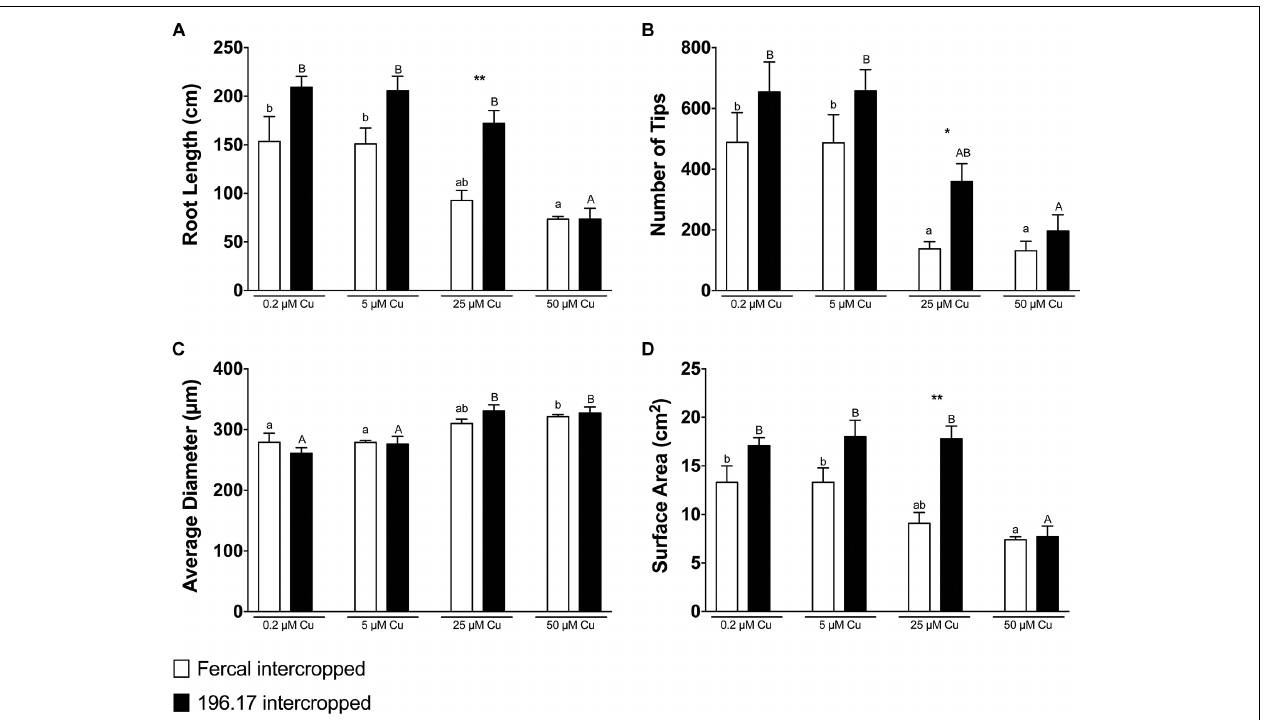
FIGURE 4 | Root architecture parameters of oat, intercropped with either Fercal or 196.17 rootstock plants, ad exposed to increasing concentration of Cu. (A) Total root length. (B) Total number of tips. (C) Average diameter. (D) Total surface area. Data have been collected at harvest (14 days after Cu treatment) and are reported as means ( ± SE), n = 5. Different letters indicate significantly different values as determined using one-way ANOVA with Tukey post hoc tests ( p < 0.05). Lower-case letters account for statistical analyses of oat plants intercropped with Fercal rootstock plants and exposed to different Cu concentrations. Upper-case letters account for statistical analyses of oat plants intercropped with Fercal rootstock plants and exposed to different Cu concentrations. Within the same Cu concentration condition, the difference between Fercal-intercropped oat and 196.17-intercropped oat was tested through a Students t -test ( ∗ p < 0.05; ∗∗ p < 0.01).